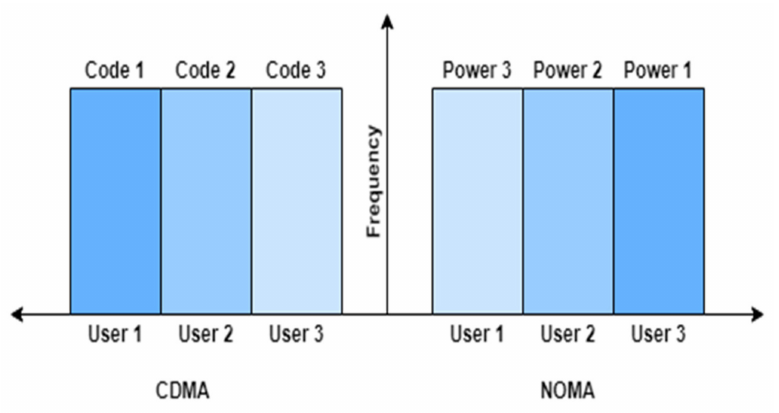
Figure 2. Multiple access using CDMA and